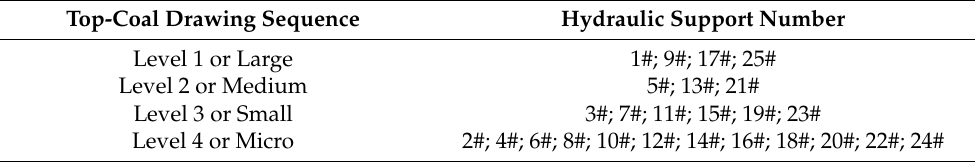
Table 2. Numerical simulation